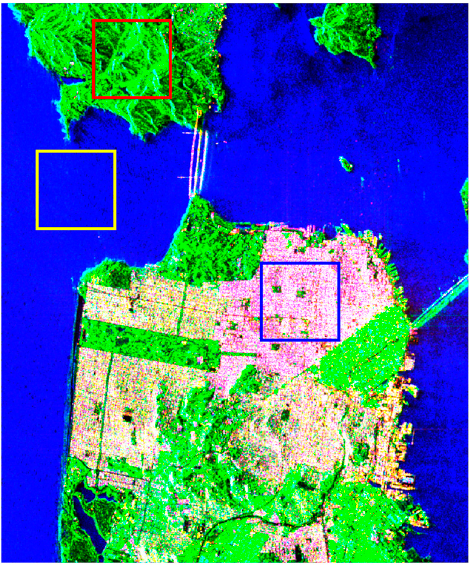
P (red), P (green), d v